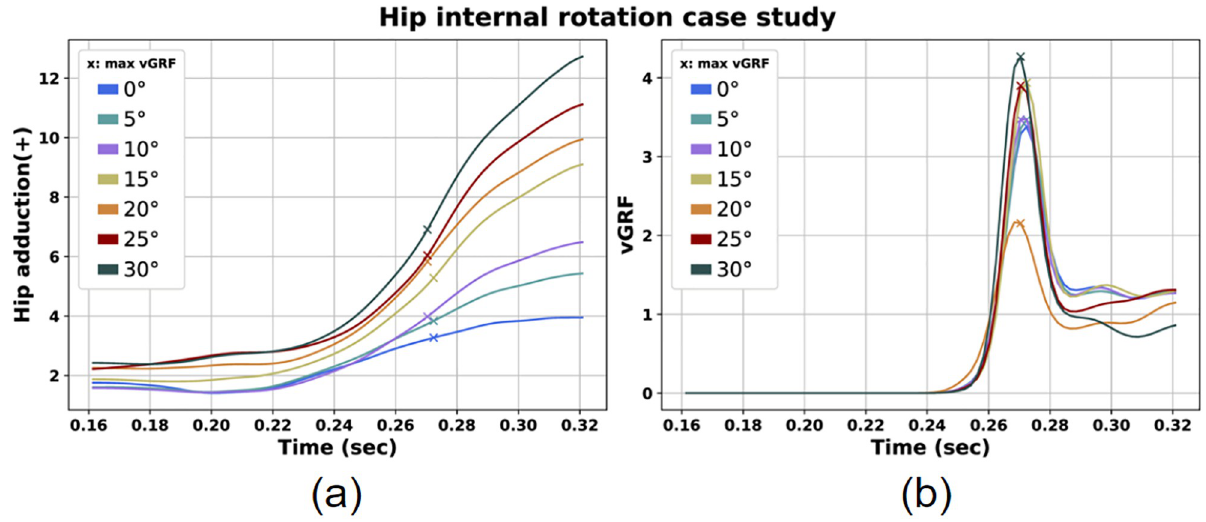
Fig 6. Hip adduction (a) and vGRF (b) for the hip internal rotation case study.